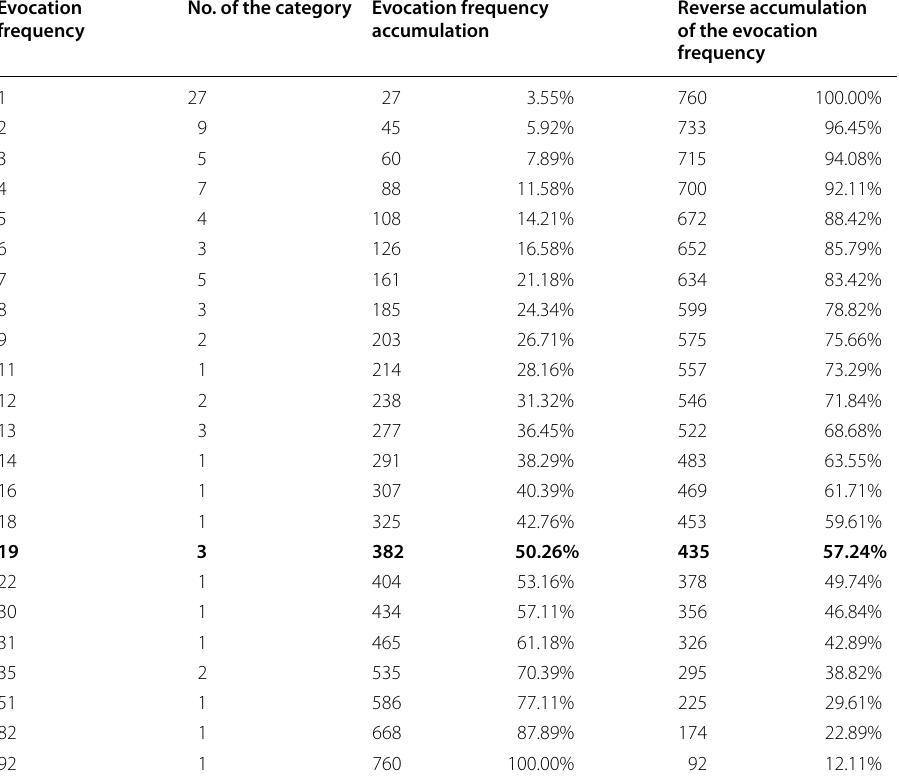
Bold indicates cut-off frequency of evocation